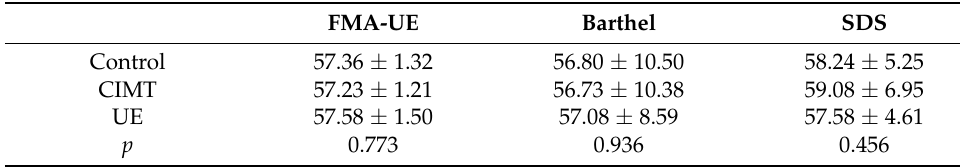
Table 3. The baseline scores of Ashworth, Barthel, and SDS.